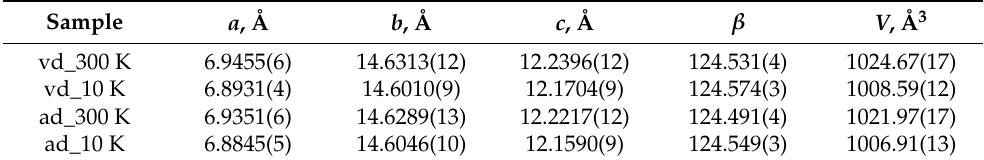
Table 1. Unit cell parameters of investigated samples, ad- and vd-KMFCN, at 10 K and 300 K data collection temperature ( SG. Pc